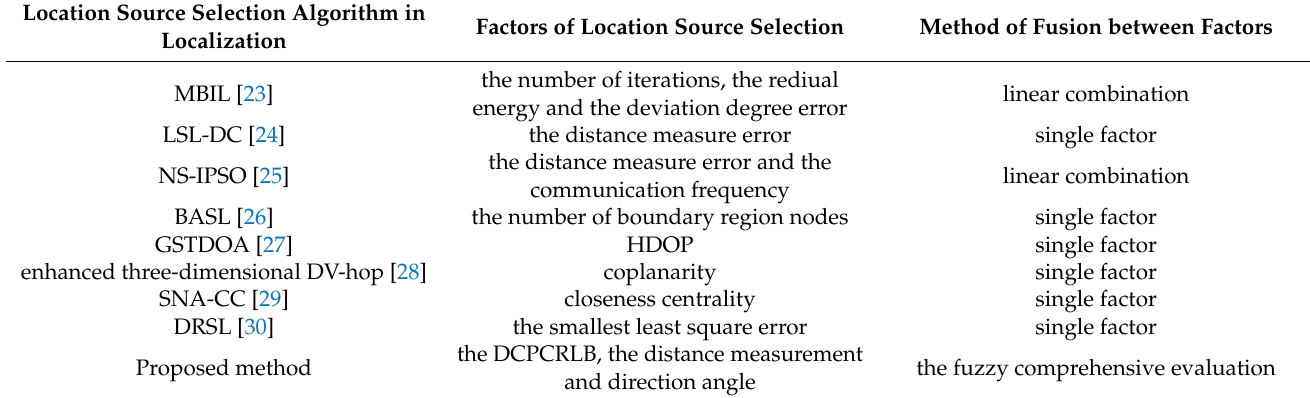
Table 1. Comparative of different location source selection algorithms.